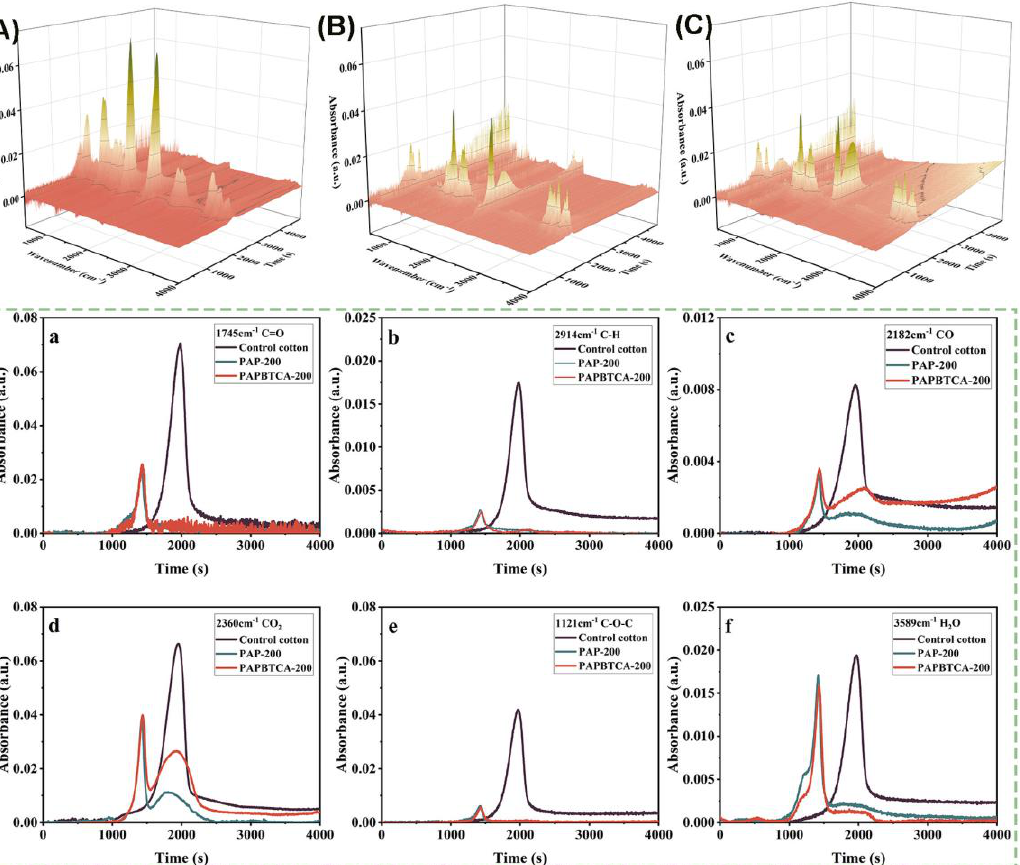
Figure 9. Three-dimensional TG-FTIR spectra of the control cotton ( A ), PAP-200 ( B ), and PAPBTCA- 200 ( C ), and the absorption intensities of selected peaks during the thermal degradation process of samples ( a – f ).